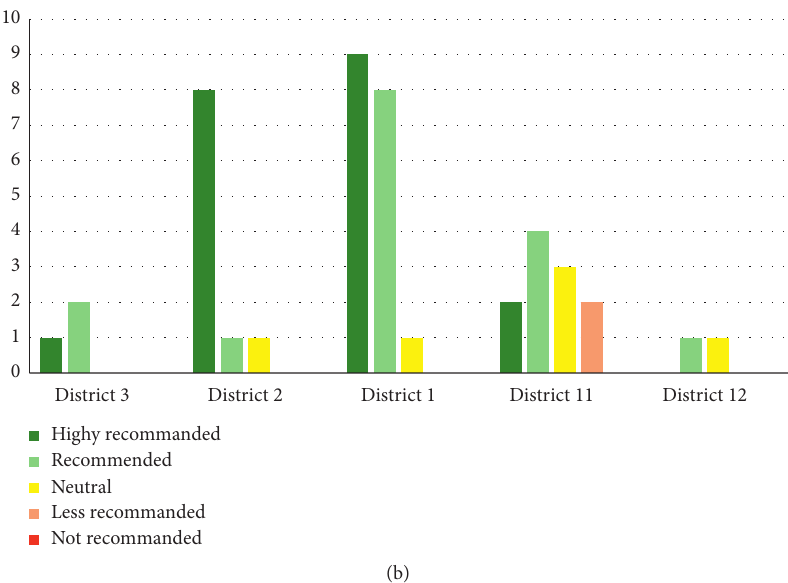
Figure 8: The places of accommodation per district in both sides of Budapest City. (a) Pest side. (b) Buda